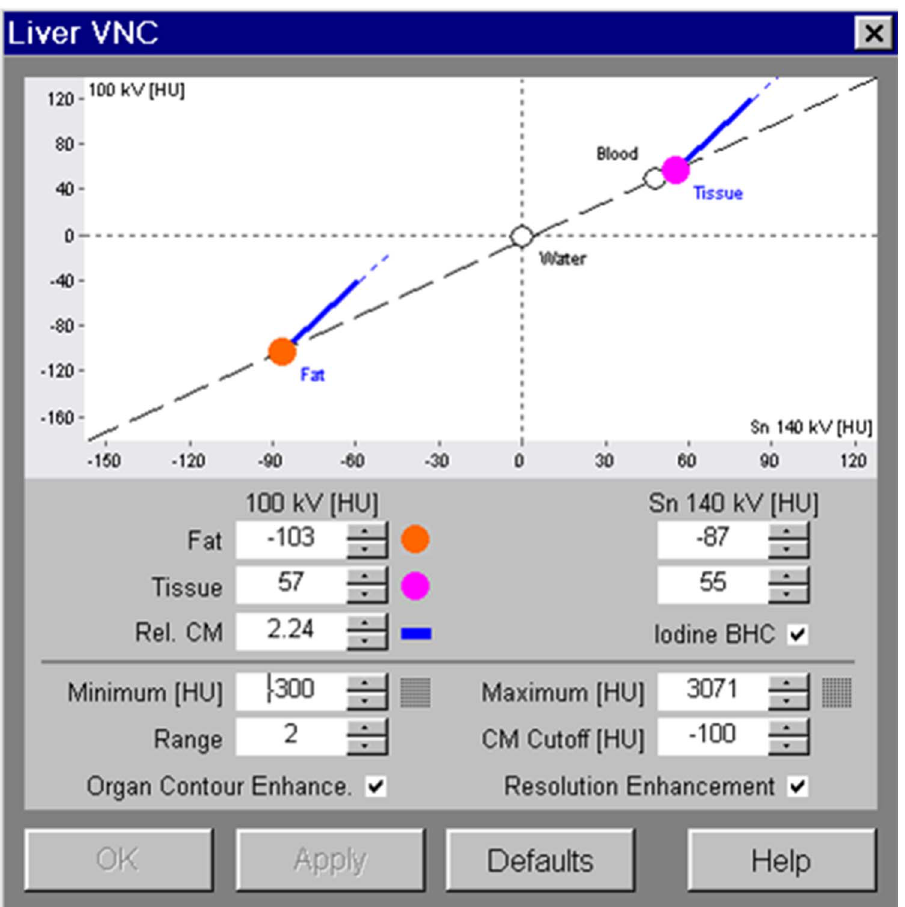
Figure 2. Standard values applied for analysis of soft-tissue and fat-tissue attenuation.